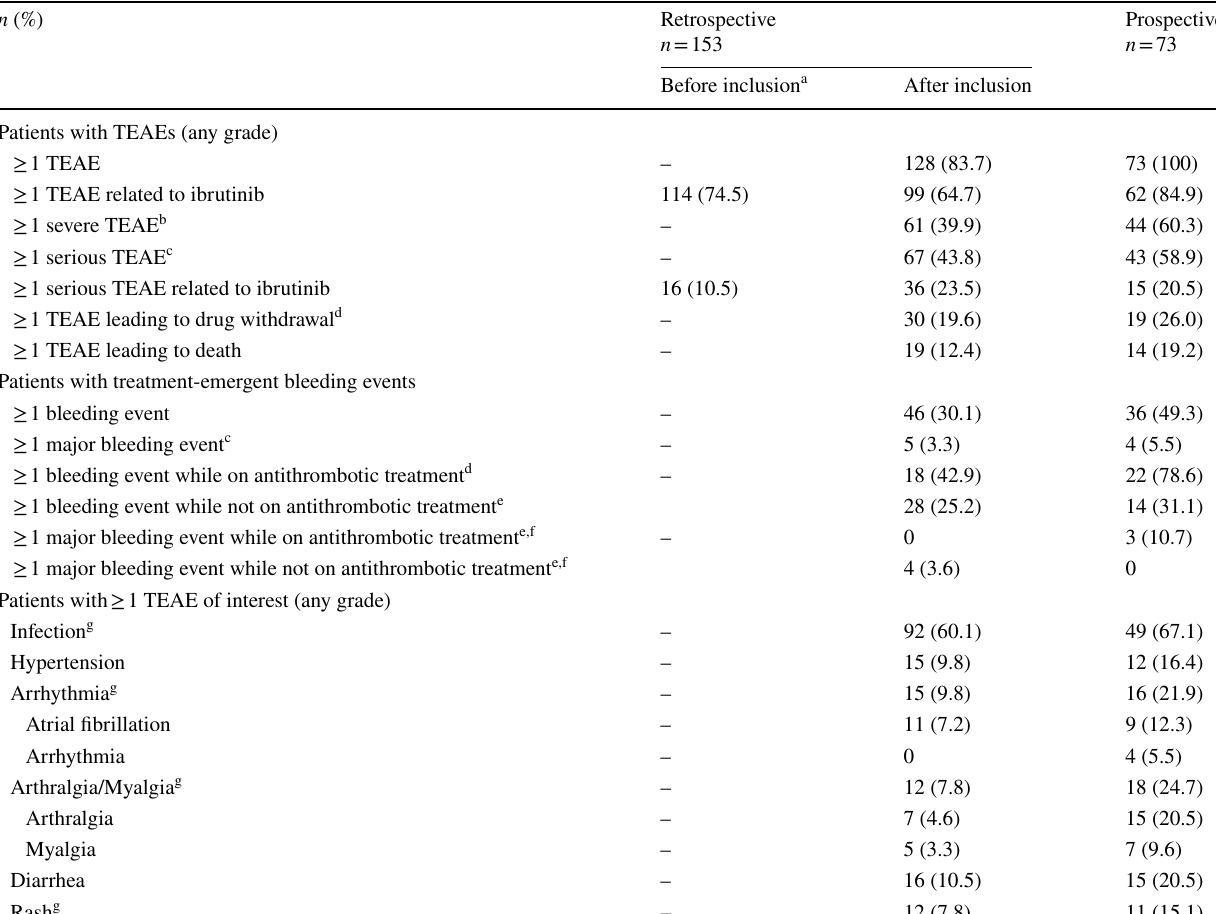
Table 3 Treatment-emergent adverse events (TEAE) of